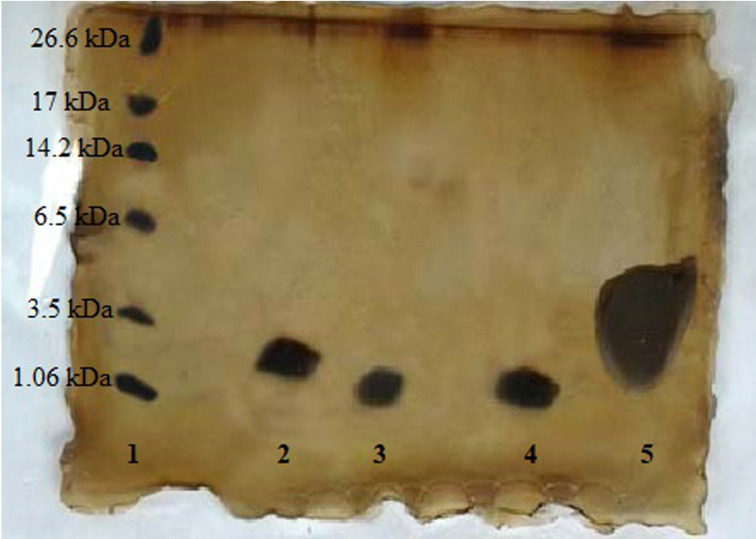
Tricine SDS page analysis.Lane 1: Ladder, Lane 2: Pure P5, Lane 3: Pure P435, Lane 4: P5+435, and Lane 5: Lip-DOPE-P5+435. The peptide concentration of sample was 2 μg/μl.